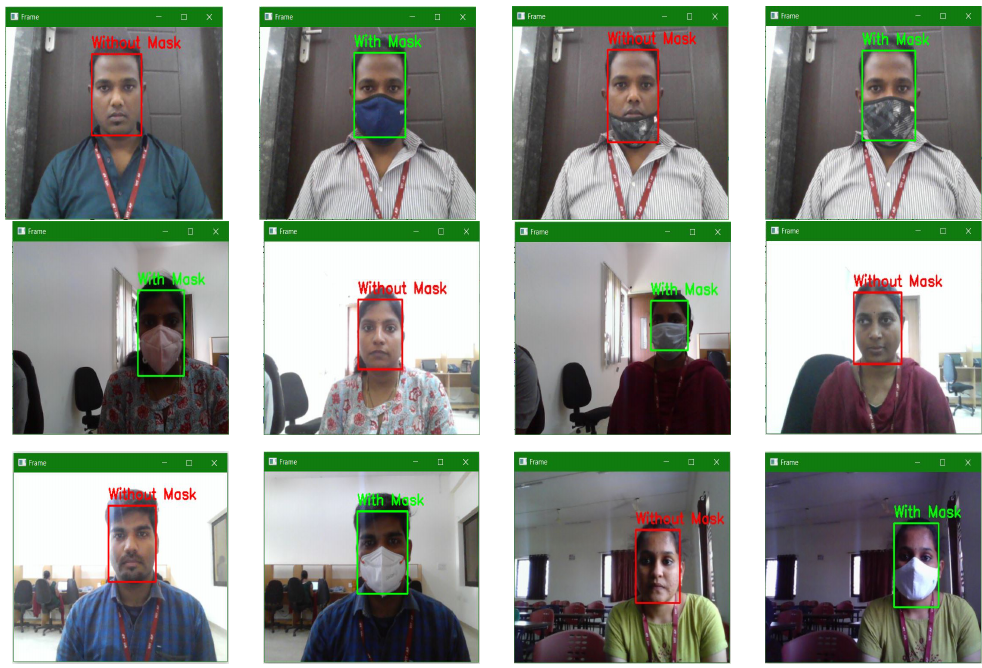
Figure 11. Face detection with and without masks in real-time video